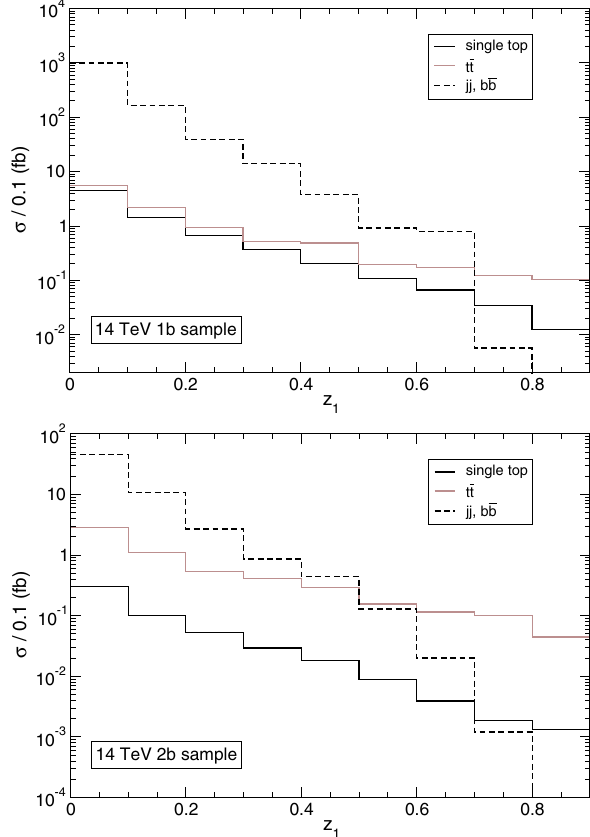
Fig. 5 Signalandbackground crosssectionsasafunctionofthelepton momentum fraction z 1 after the final selection in the 1 b (top) and 2 b (bottom) samples, for a CM energy of 14 TeV